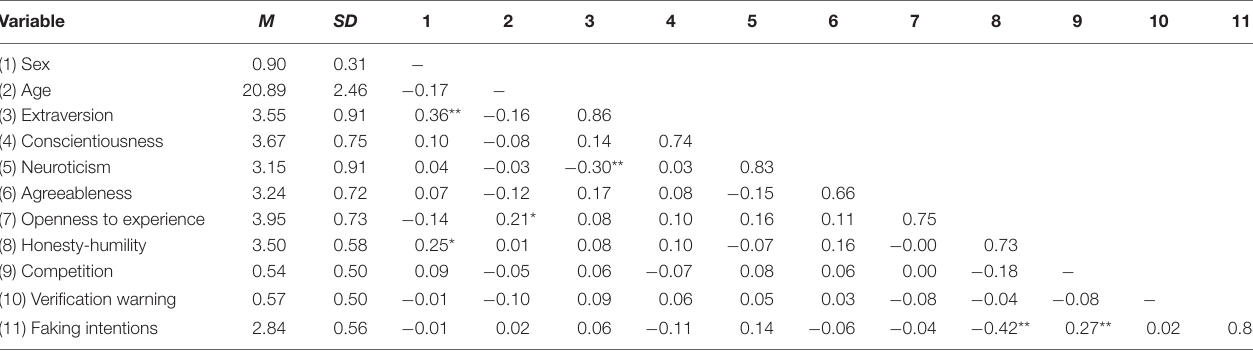
TABLE 1 | Correlations, means, and standard deviations among all study variables in Study 1. Variable